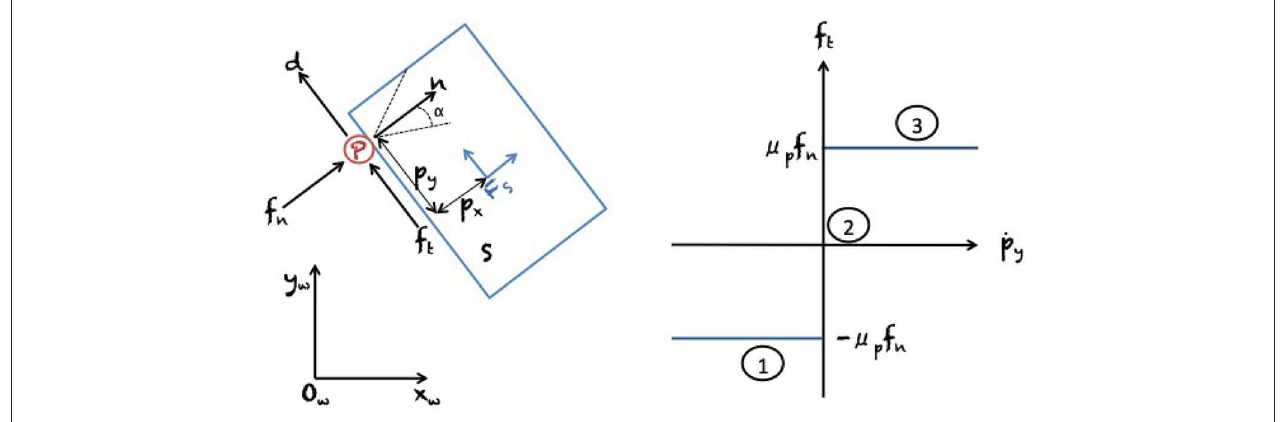
FIGURE 4 | (Left) Planar pushing system with world frame F w (with origin O w ) and a slider S (blue) with frame F w as described in Figure 3 . The pusher P (red) is interacting with the slider on one point of contact. It impresses a normal force f n , a tangential friction force f t , and a torque τ about the center of mass. The normal force f n is in the direction of the normal vector n of the contact point between pusher and slider, and α = arctan µ p is the angle of the friction cone assuming µ p as the coefficient of friction. The terms p x and p y describe, respectively, the normal and the tangential distance between the pusher P and the center of friction of the slider S . (Right) Coulomb’s frictional law for the planar pushing system on the left-hand figure. Coulomb’s law states that the normal and tangential forces are related by f t = µ p f n . Three contact modes are defined. (1) Sliding right in which friction acts as a force constraint; (2) Sticking in which friction acts as a kinematic constraint; and (3) Sliding left in which friction acts as a force constraint. Reproduced from Bauza et al.